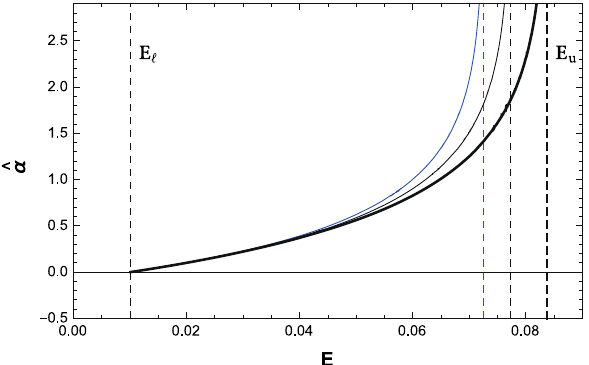
Fig. 6 The behavior of the deflection angle ˆ α in terms of E , demon- strated for L = 1, M = 1 and (cid:4) = 10. Black-thin line for Q = 1 . 2, black-thick line Q = Q ext = 1 . 40, and blue line for Q = 0. As expected, the deflection angle reaches its limit as E tends to E u which for Q = 1 . 20 is around 0 . 077, for Q = Q ext is 0 . 084 and it is 0 . 073 for Q =